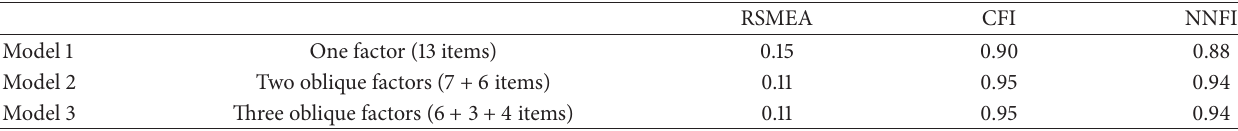
Table 2: Goodness of fit indices of the different used models.